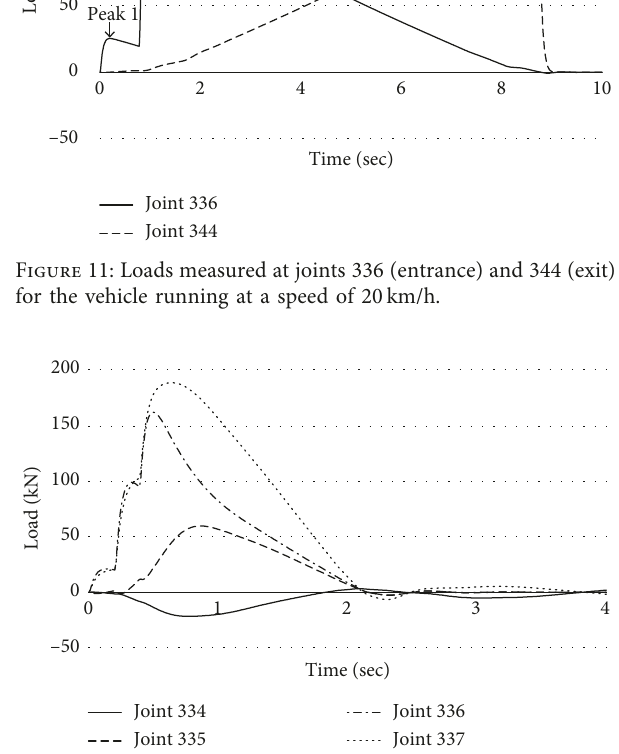
Figure 12: Loads measured by BWIM bearings at the entrance side (speed �